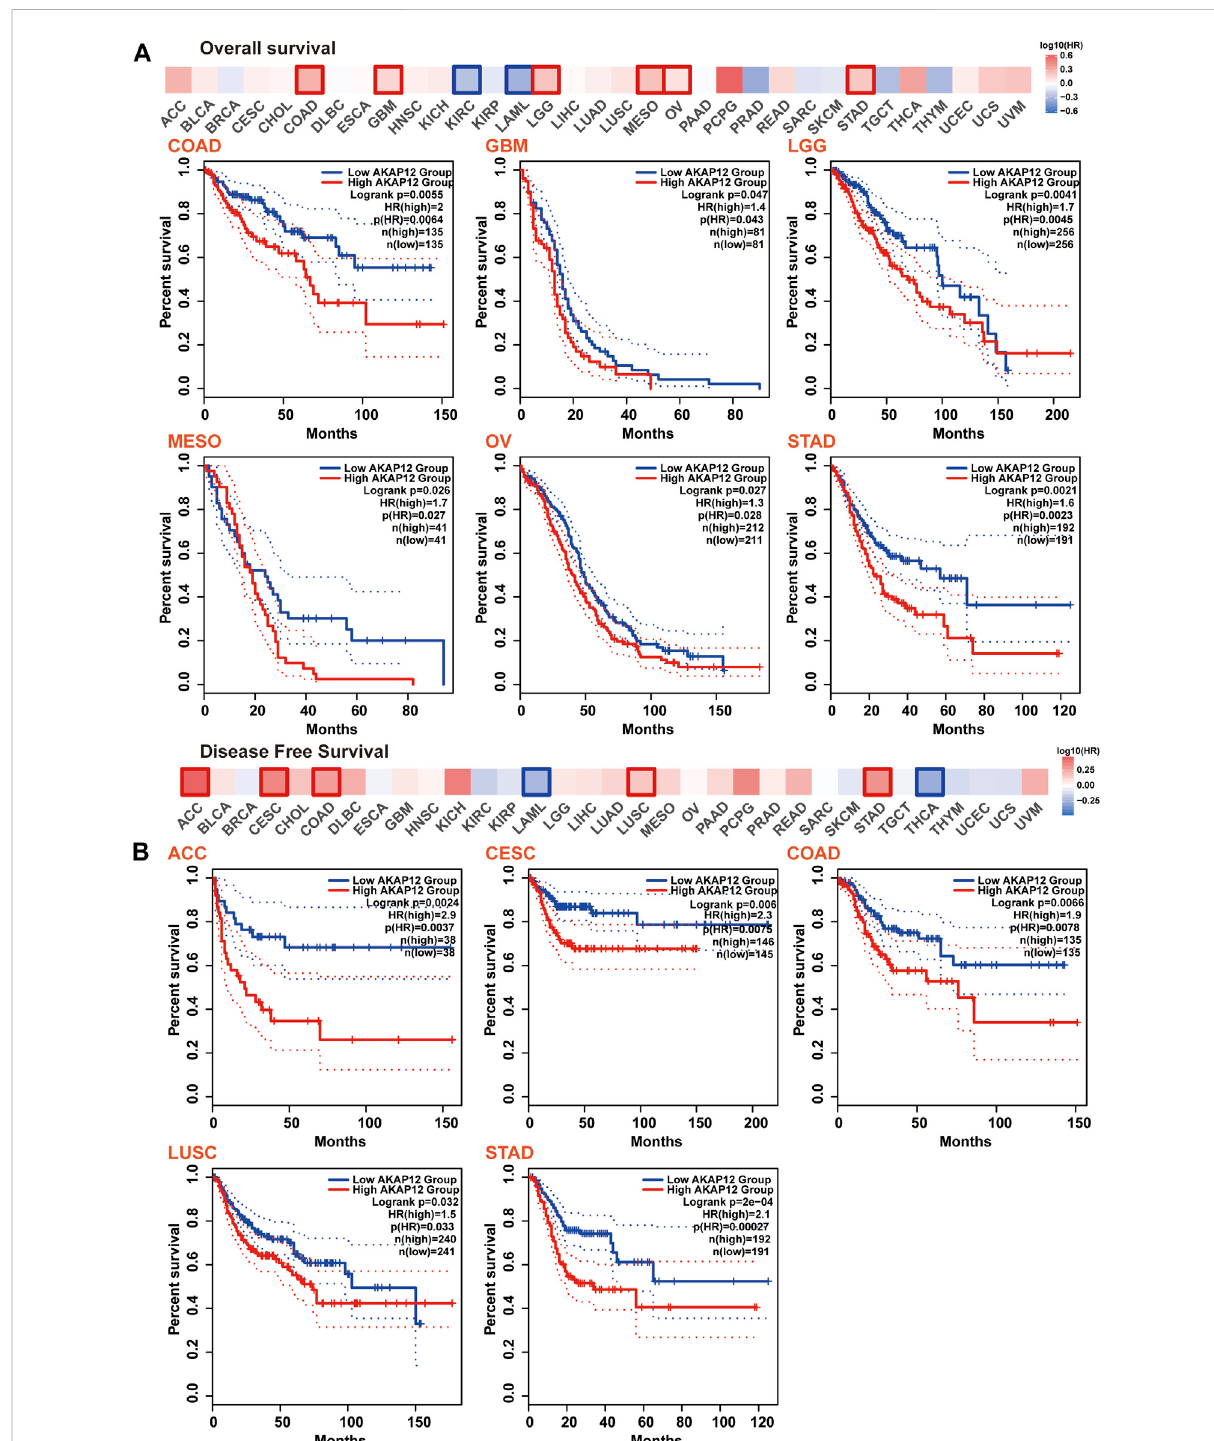
FIGURE 3 Correlation between AKAP12 expression and patient survival across all TCGA tumors. Correlation between AKAP12 expression and overall survival (A) , disease-free survival (B) were evaluated among TCGA cancers employing GEPIA2. Only signi fi cantly negative correlations between AKAP12 expression and prognosis were visualized by Kaplan-Meier